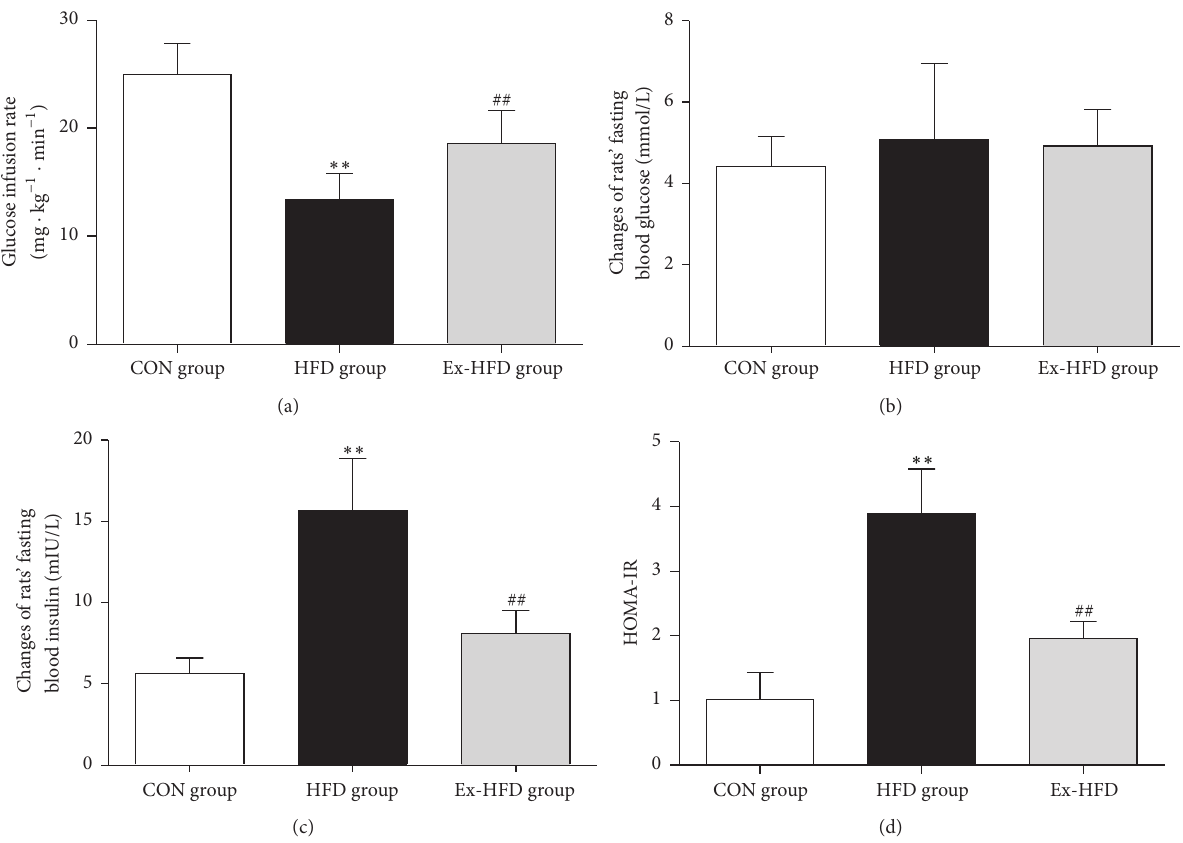
Figure 2: Blood glucose, insulin, and insulin resistance index in the three groups. (a) The fasting blood glucose in three groups at the 8th week. There were no significant differences in the fasting blood glucose measured after 8-week swimming exercise intervention compared with the untreated high-fat-diet group. (b) The fasting blood insulin in three groups at the 8th week. There was significant decrease in the fasting blood insulin that was measured after 8-week swimming exercise intervention compared with the untreated high-fat-diet group. (c) The GIR of three groups. The GIR is commonly used in evaluating insulin resistance. After training with swimming exercise, GIR in group Ex- HFD was significantly increased. (d) HOMA-IR value of three groups at the 8th week, which was also selected to evaluate insulin resistance. After training with swimming exercise, HOMA-IR was improved. ∗∗ 𝑝 < 0.01 , versus CON group; ## 𝑝 < 0.01 , versus group HFD group.